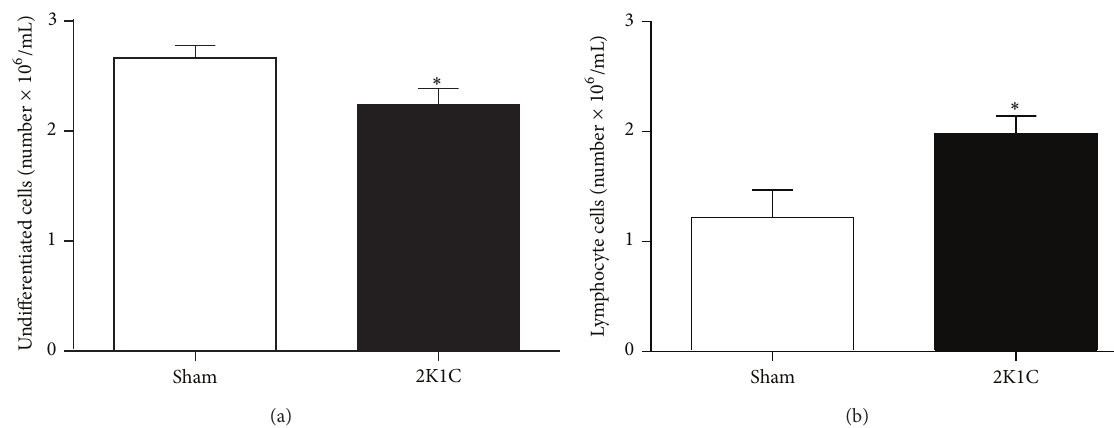
Figure 2: Neubauer chamber analysis of bone marrow mononuclear cells from Angiotensin-II-dependent hypertensive (2K1C, 𝑛 = 10 ) and normotensive (Sham, 𝑛 = 10 ) mice. Values of lymphocytes and undifferentiated cells are the means ± SEM. ∗ 𝑃 < 0.05 versus Sham group (Student’s 𝑡 test for independent